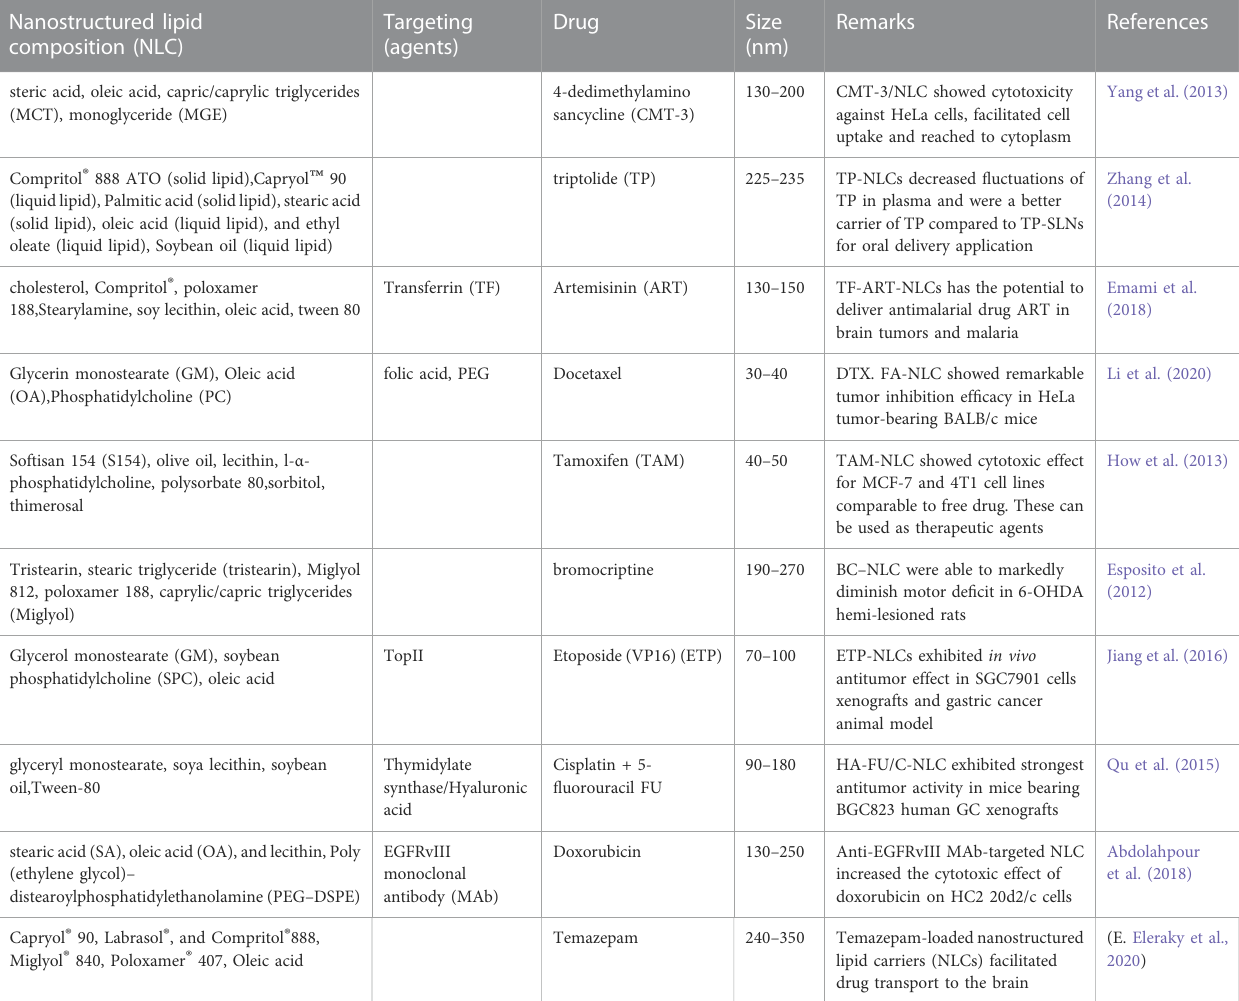
TABLE 2 Examples of nanostructured lipidic carrier formulations. Nanostructured lipid composition